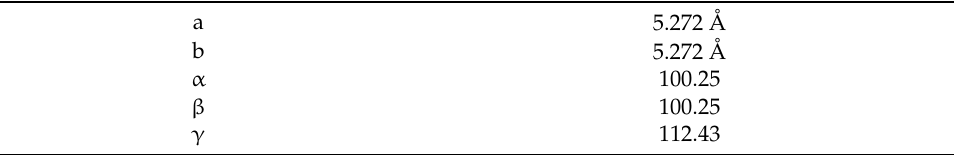
Table 1. Structural parameters of the Cu 2 TeO 6 monolayer.